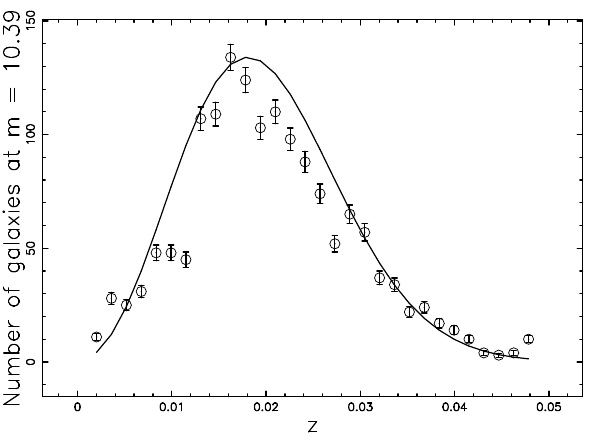
Figure 2. The galaxies of the 2MRS with 10.31 ≤ m ≤ 10.47 or L ⊙ L ⊙ 1164793 ≤ f ≤ 1346734 are organized in frequencies Mpc 2 Mpc 2 versus heliocentric redshift, (empty circles); and, the error bar is given by the square root of the frequency. The maximum frequency of observed galaxies is at z = 0.017. The full line is the theoretical Figure 3. All the galaxies for 2MRS are organised in frequencies ver- curve generated by dN ( z ), see equation (10), and the maximum sus redshift, (empty circles); the error bar is given by the square dΩdzdf is at z = 0.0133. The parameters are given in Table 1. root of the frequency. The maximum frequency of the observed galaxies is at z = 0.017. The full line is the theoretical curve gen- erated by the integral equation (16), which has maximum is at z = 0.0237. The parameters are given in Table Table 1. Parameters of the Schechter LF before scaling with h.